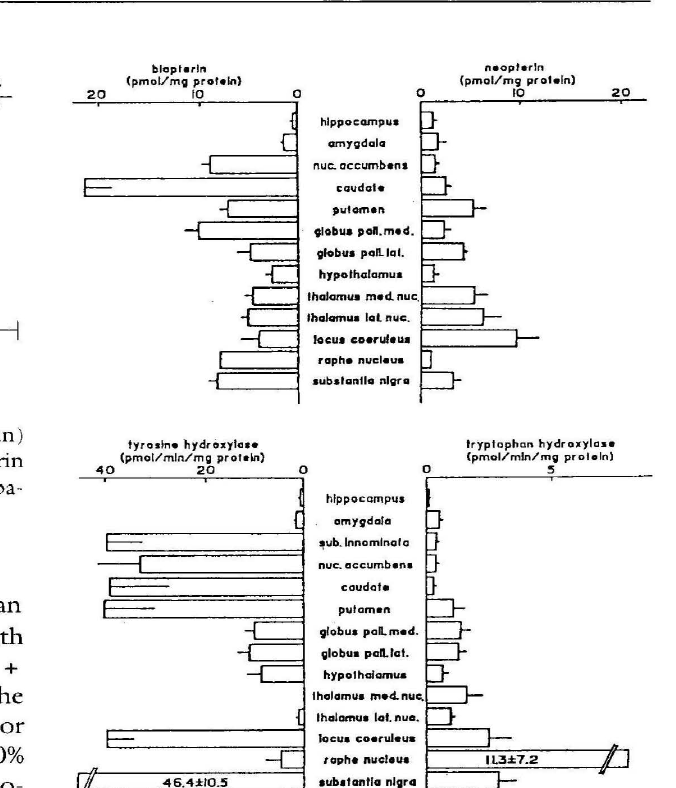
Figure 1. Mean contents of neopterin (hatched coulmn) and biopterin (filled conlmn) (left) and ratio of neopterin to biopterin (right) in urine frGm control and cancer pa tients. Column and bar represent means ± SEM.